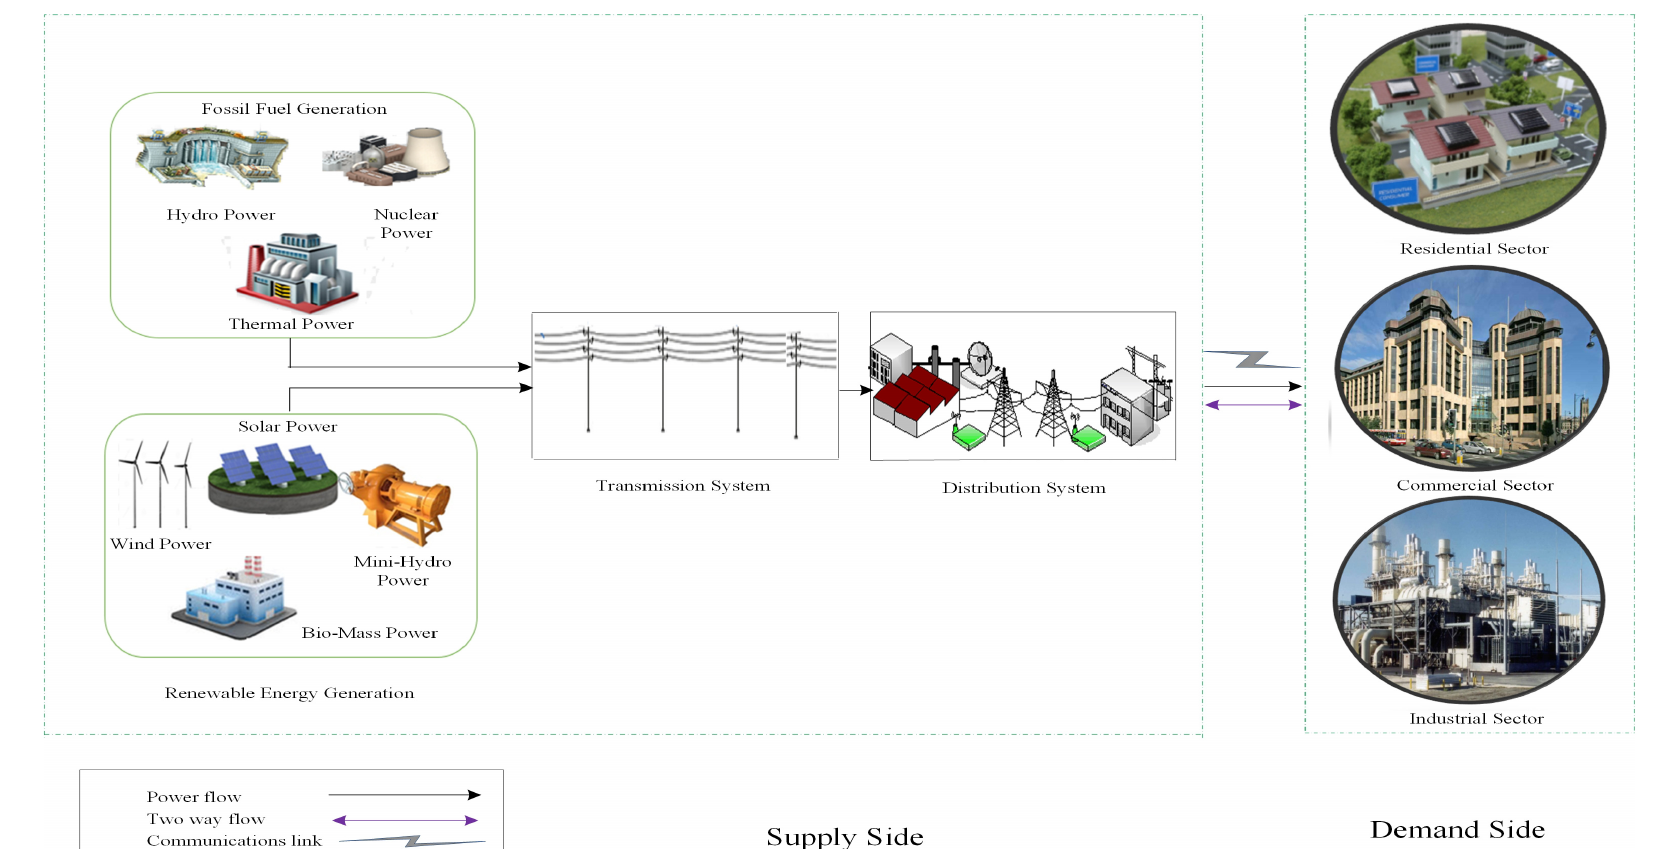
Figure 1. Abstract view diagram of power flow for supply and demand